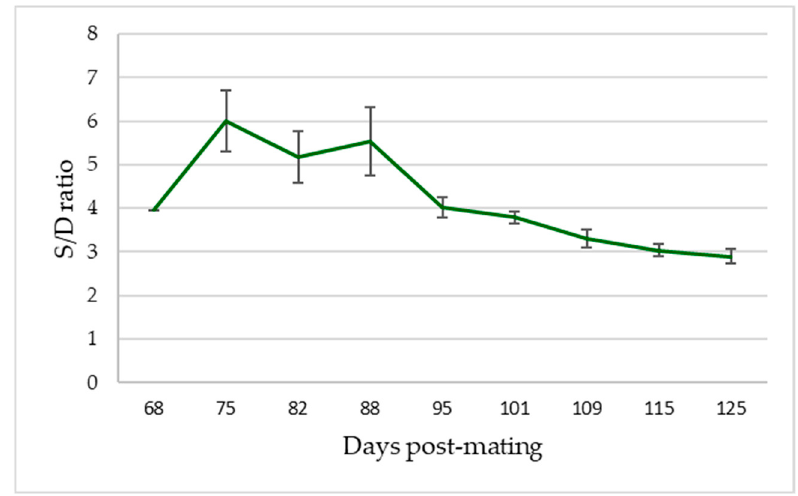
Figure 6. Evolution curve of Systolic/Diastolic ratio (S/D) in total goats under study ( n : 9). The mean and the standard deviation of the measurements are plotted in relation to the days after mating.